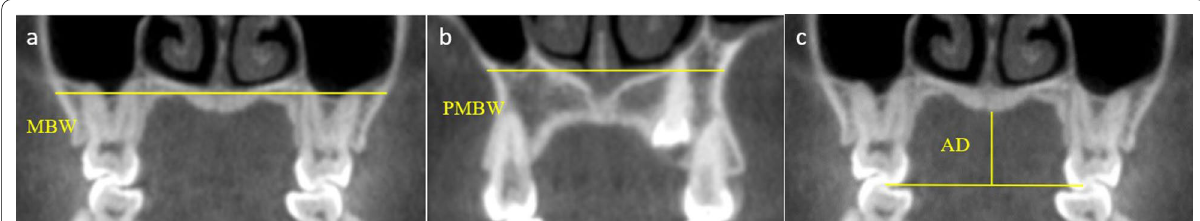
Fig. 2 The quantitative basal measurements: a MBW, first molar basal width; b PMBW, first premolar basal width; and c AD, arch depth